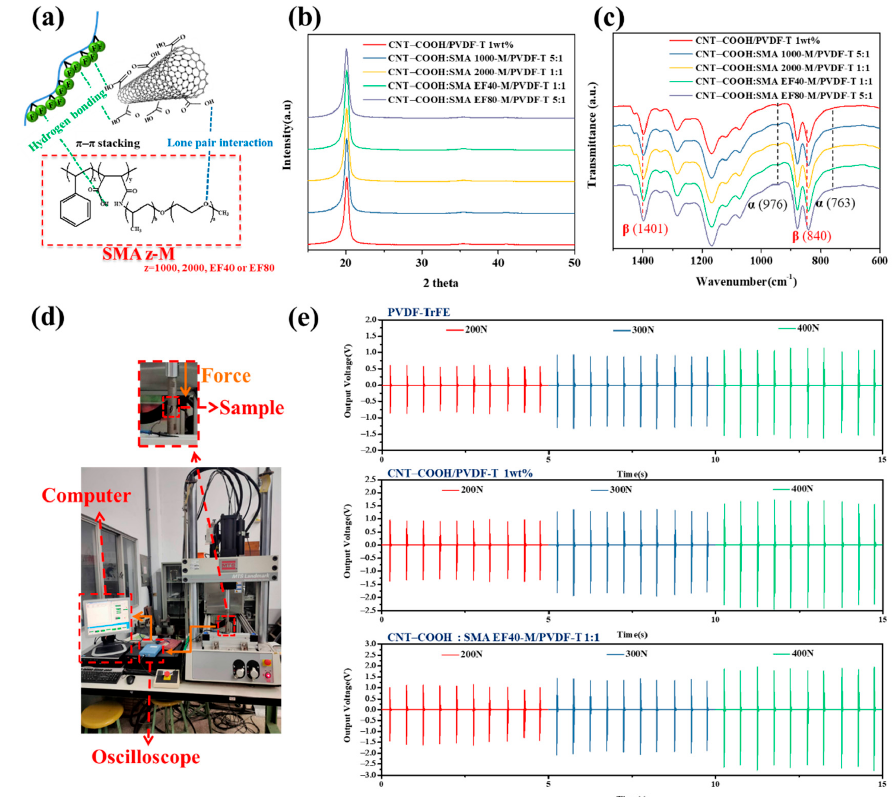
Figure 6. ( a ) Schematic of the polymeric dispersant interacting with CNT–COOH and PVDF-TrFE. ( b ) XRD and ( c ) FTIR curves of CNT–COOH:SMAzM/PVDF-T with different polymeric dispersants at the optimal ratio. ( d ) Photograph of continuous output voltage test setup and ( e ) the continuous output voltage curve of PVDF-TrFE, 1 wt% CNT–COOH/PVDF-T, and 1:1 CNT–COOH:SMA EF40-M/PVDF-T under different pressures. Table 3. Continuous output voltage results of PVDF-TrFE, CNT–COOH/PVDF-T 1 wt%, and CNT– COOH:SMA EF40-M/PVDF-T 1:1.